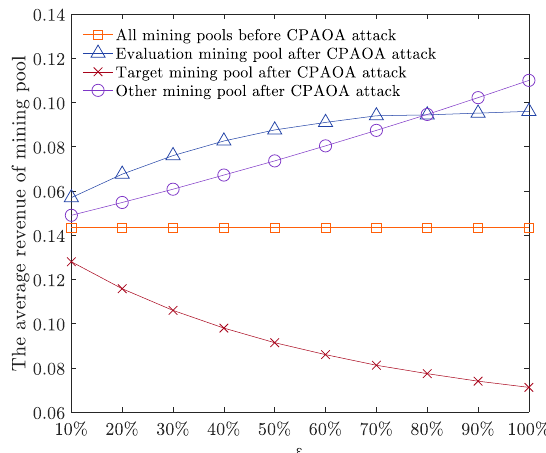
Figure 5. The average revenue of mining pool computing power before and after the attack.